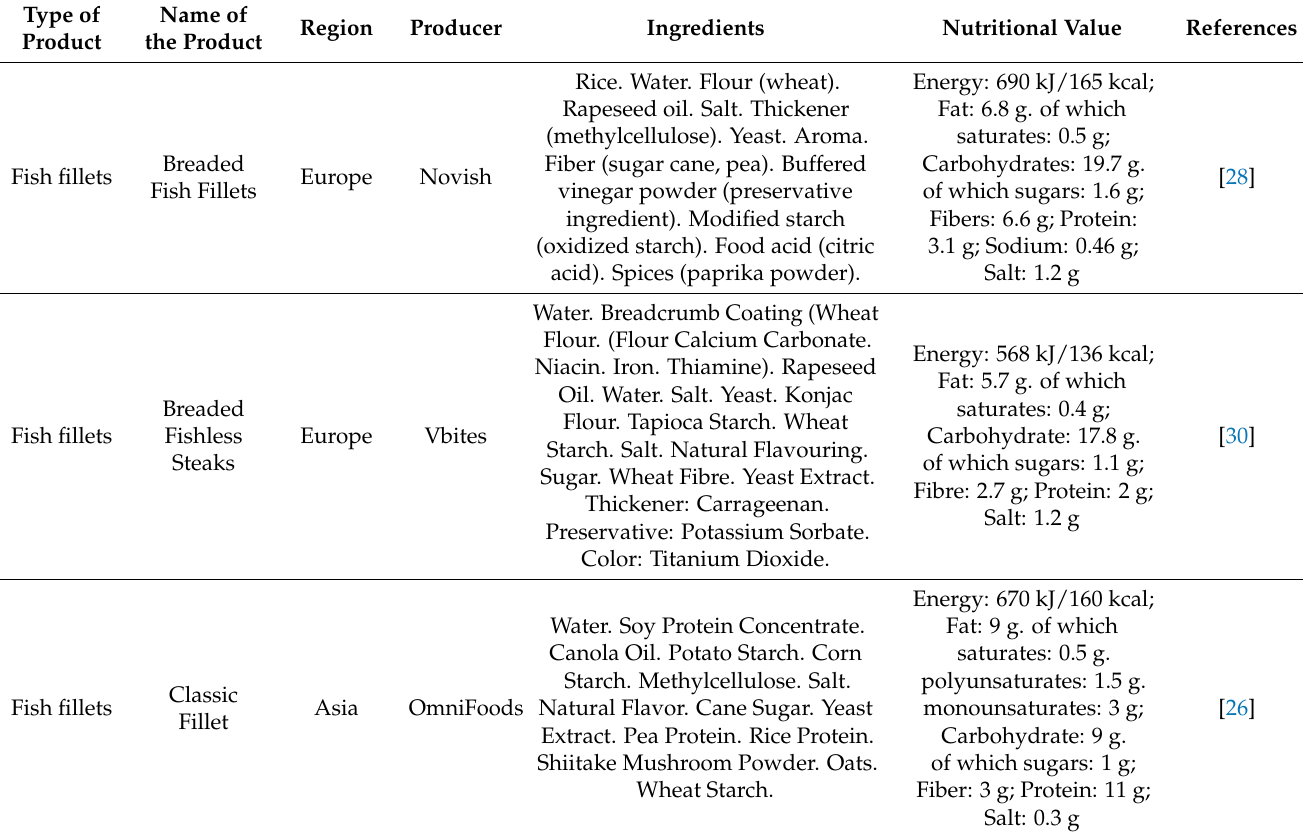
Table 1. The plant-based fish products available on the